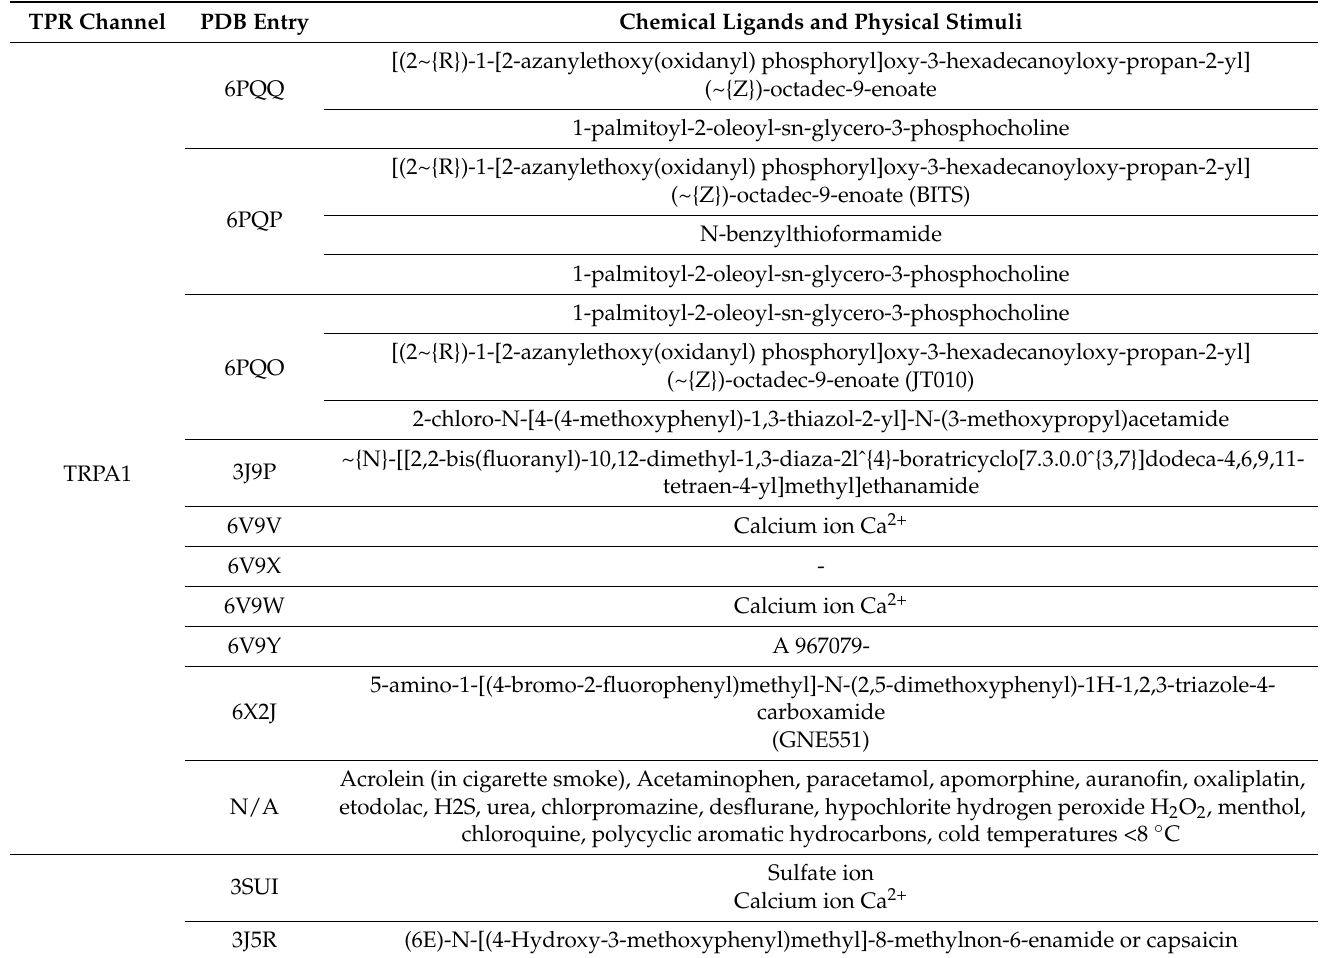
Table 5. Chemical ligands and physical